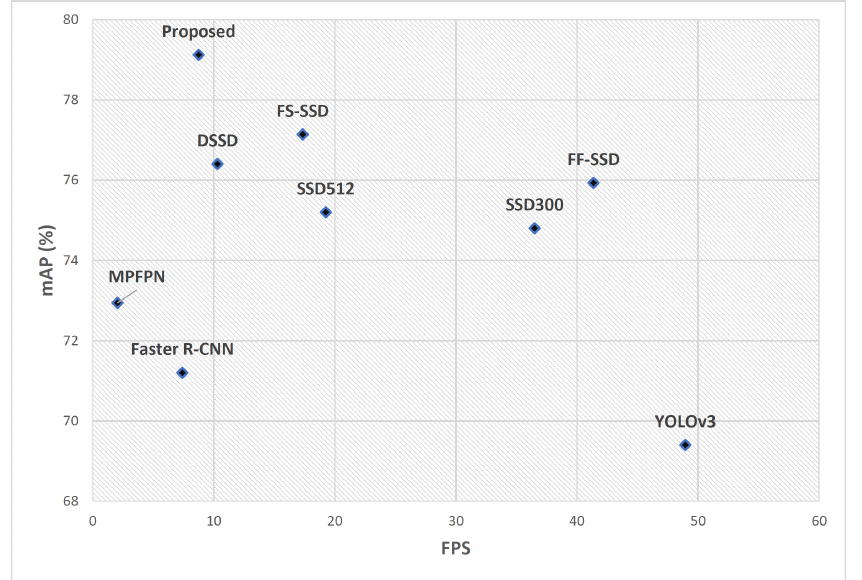
Figure 14. Speed and accuracy comparison of the proposed method with the state-of-the-art methods on the livestock dataset. It can be observed that the proposed model supersedes other approaches in terms of mAP, which makes it suitable for applications where accuracy is critically